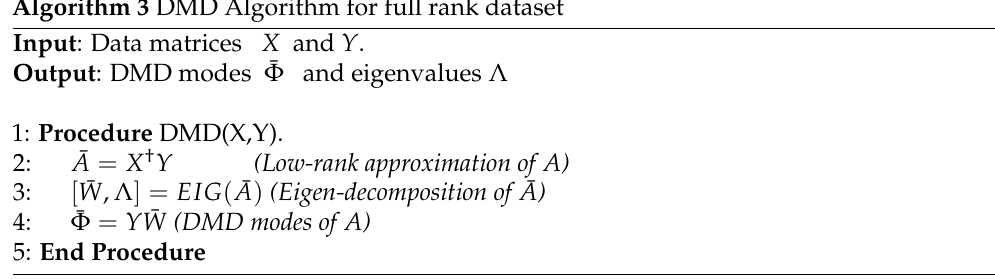
Algorithm 3 DMD Algorithm for full rank